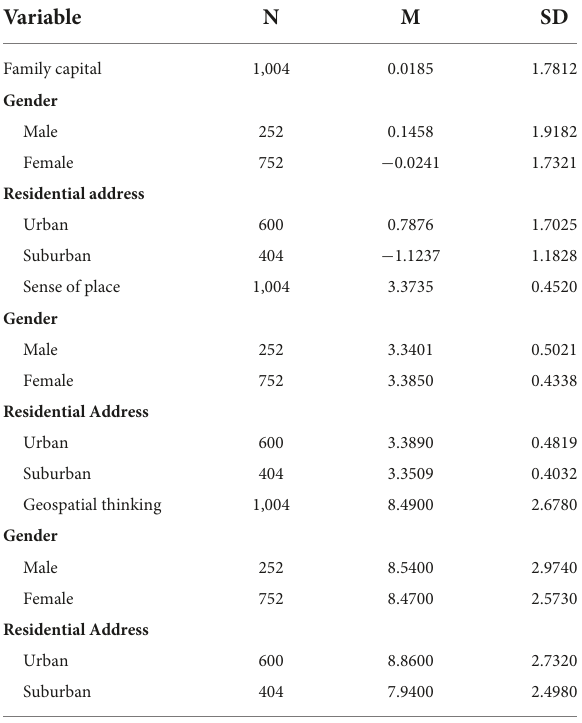
TABLE 1 Descriptive statistics for the three variables.